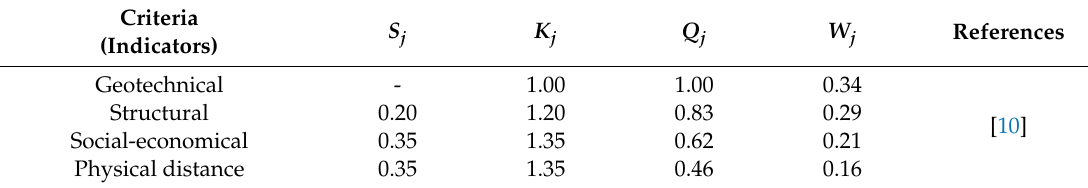
Table 3. Calculated weight of criteria using SWARA.